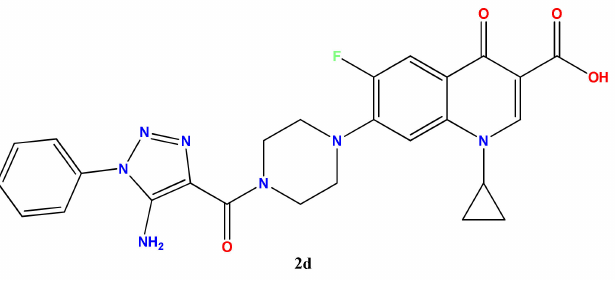
Figure 4. Compound 2d with the highest level of antibacterial activity. As a continuation of this research, we decided to check the synthesized molecule potency utilizing the diffusion in agar method and hospital strains. The results against reference and clinical strains of S. aureus and E. coli are represented in Table 3. Growth retar- dation zone exceeded 25 mm, which corresponds to the high sensitivity of microorganisms towards the tested compounds. Table 3. Activity of the synthesized compounds measured by the agar diffusion method.